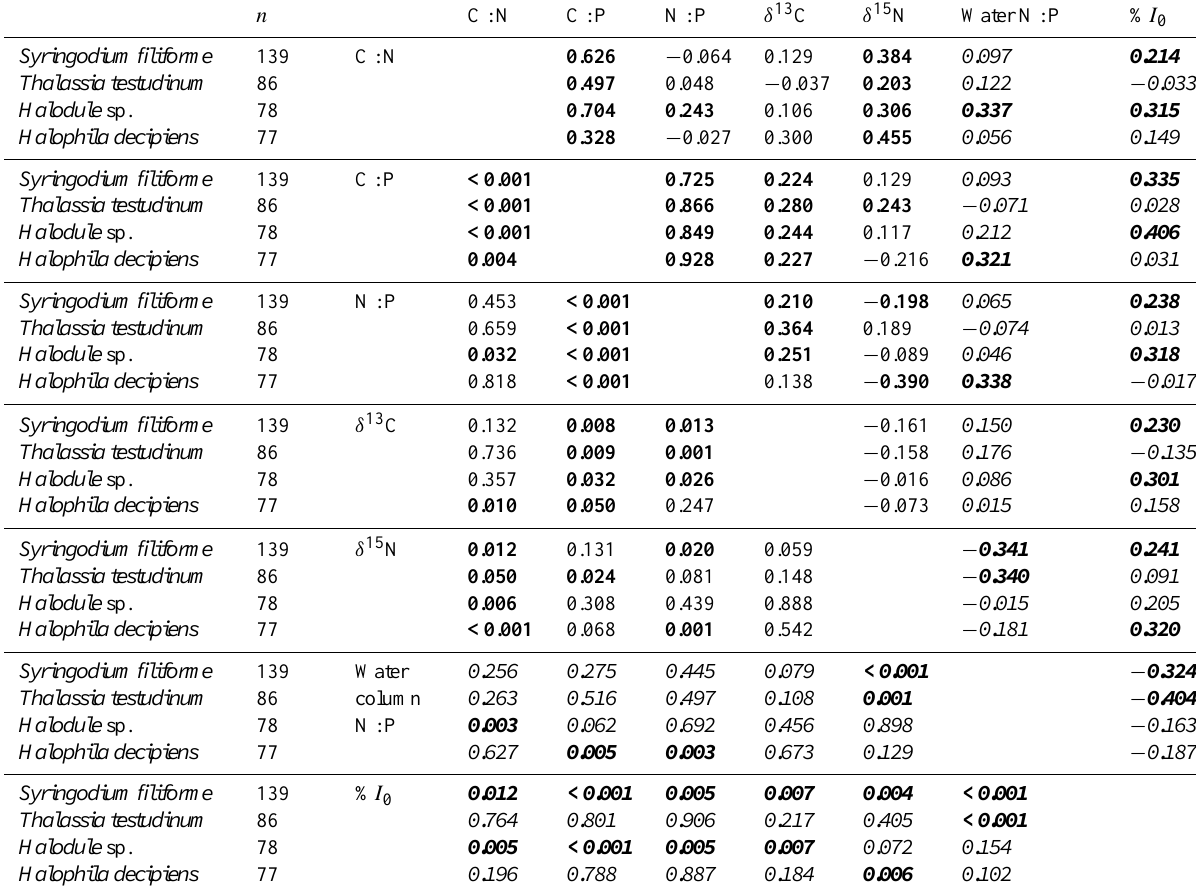
Table 3. Relationships among elemental content and stable isotope ratios for seagrasses from the Bermuda Platform. Values above the diagonal are Pearson’s correlation coefficients ( r ), below the diagonal is the two-tailed test of the significance of the correlation ( p ). Italics indicate water column parameters, boldface type indicates statistically significant relationships with p ≤ 0 . 05. n